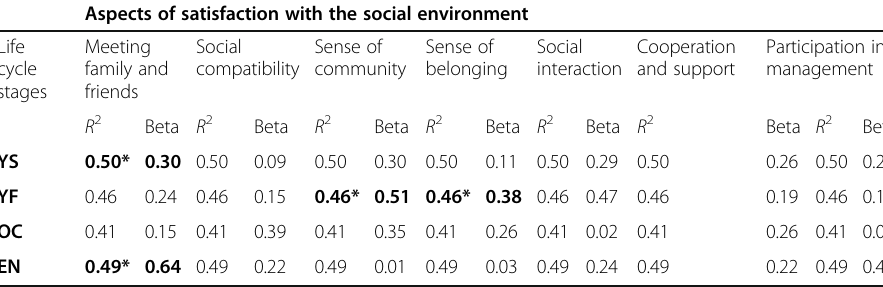
Table 14 Regression analysis results for satisfaction with the social environment Aspects of satisfaction with the social